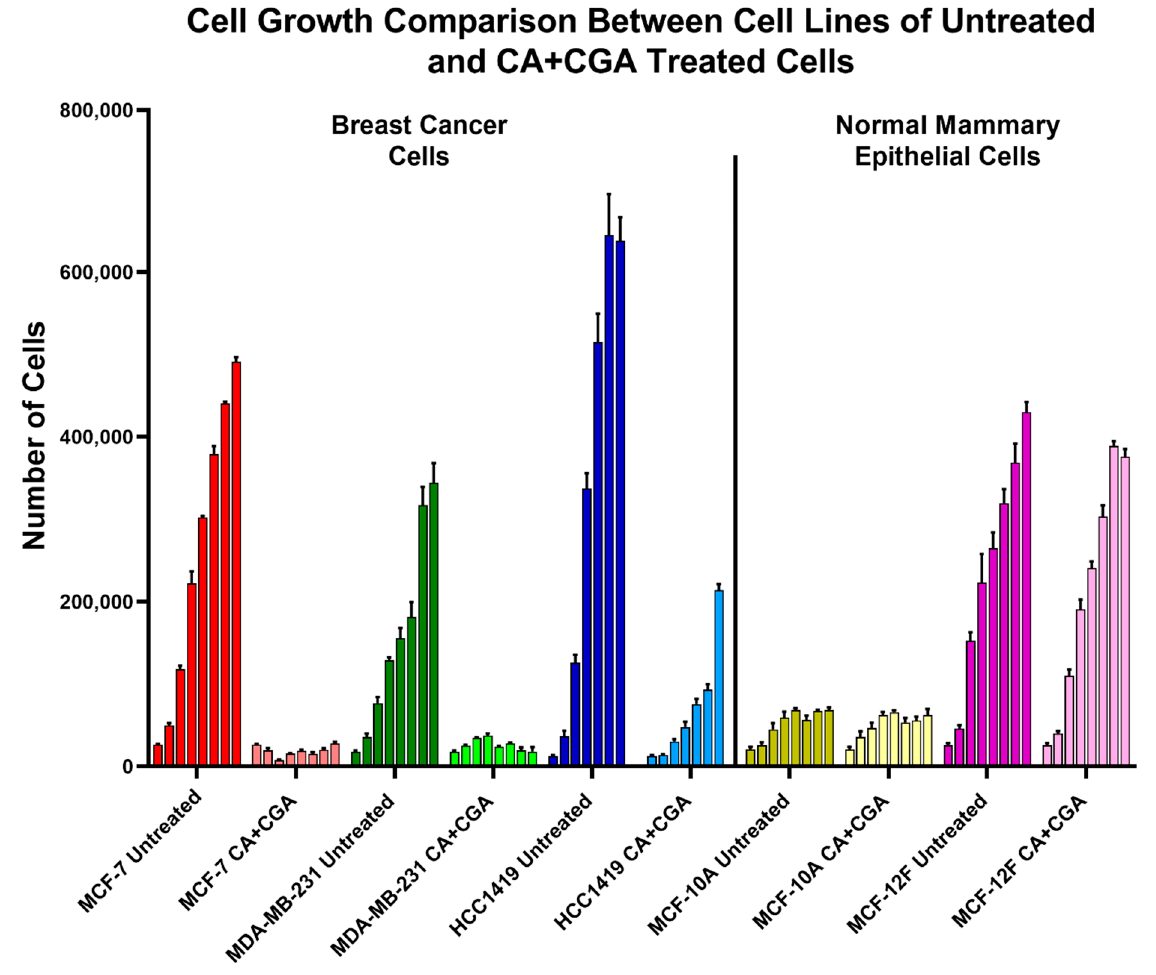
Figure 5. Cell growth comparison of untreated and CA + CGA-treated breast cancer and normal mammary epithelial cells. CA + CGA treatment significantly reduced breast cancer cell growth com- pared to untreated breast cancer cells, but did not cause cell growth reductions in normal mammary epithelial cells. Cell growth was determined by counting the number of cells in each group on each day for 6/7 days. Each bar represents the mean ± SEM of three biological replicates ( n = 3).